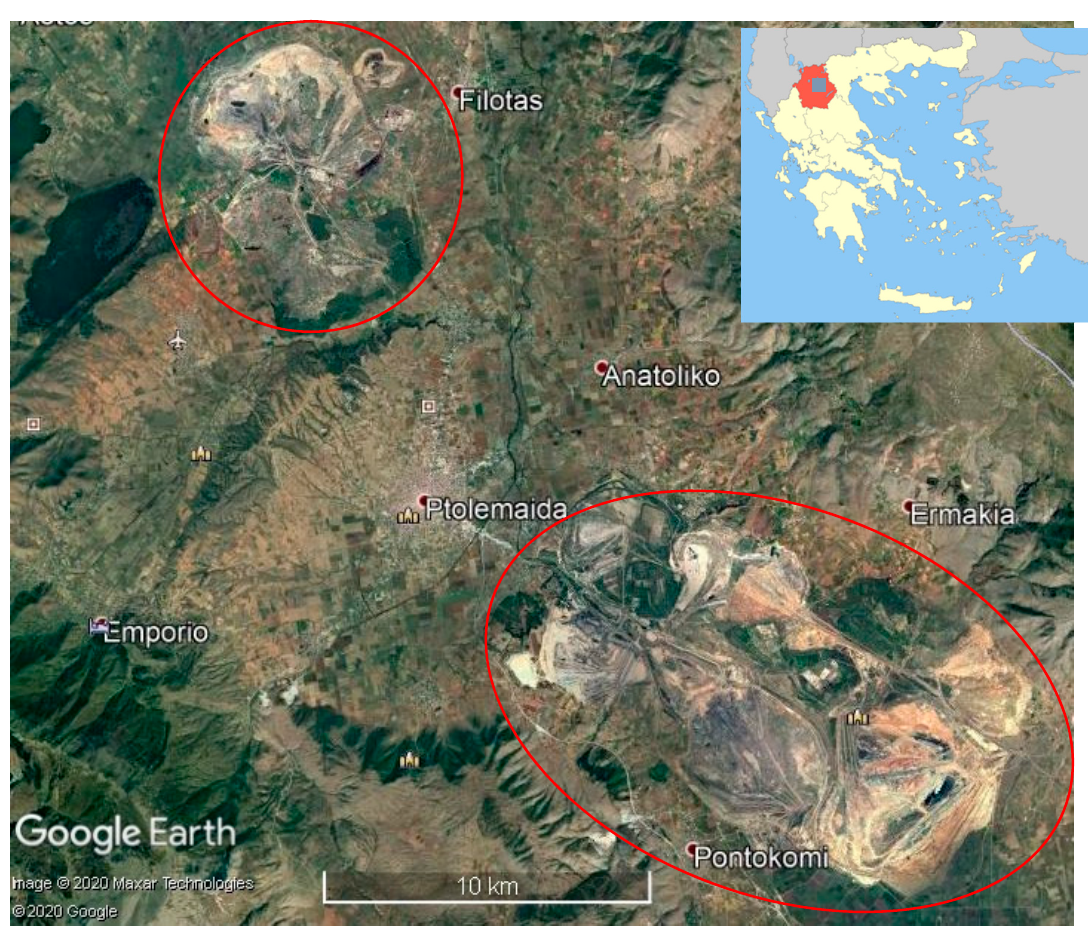
Figure 3. Satellite view of the western Macedonia Lignite Centre, with the red curves indicating the two mining areas: Amynteon (NW) and Ptolemaida (SE).